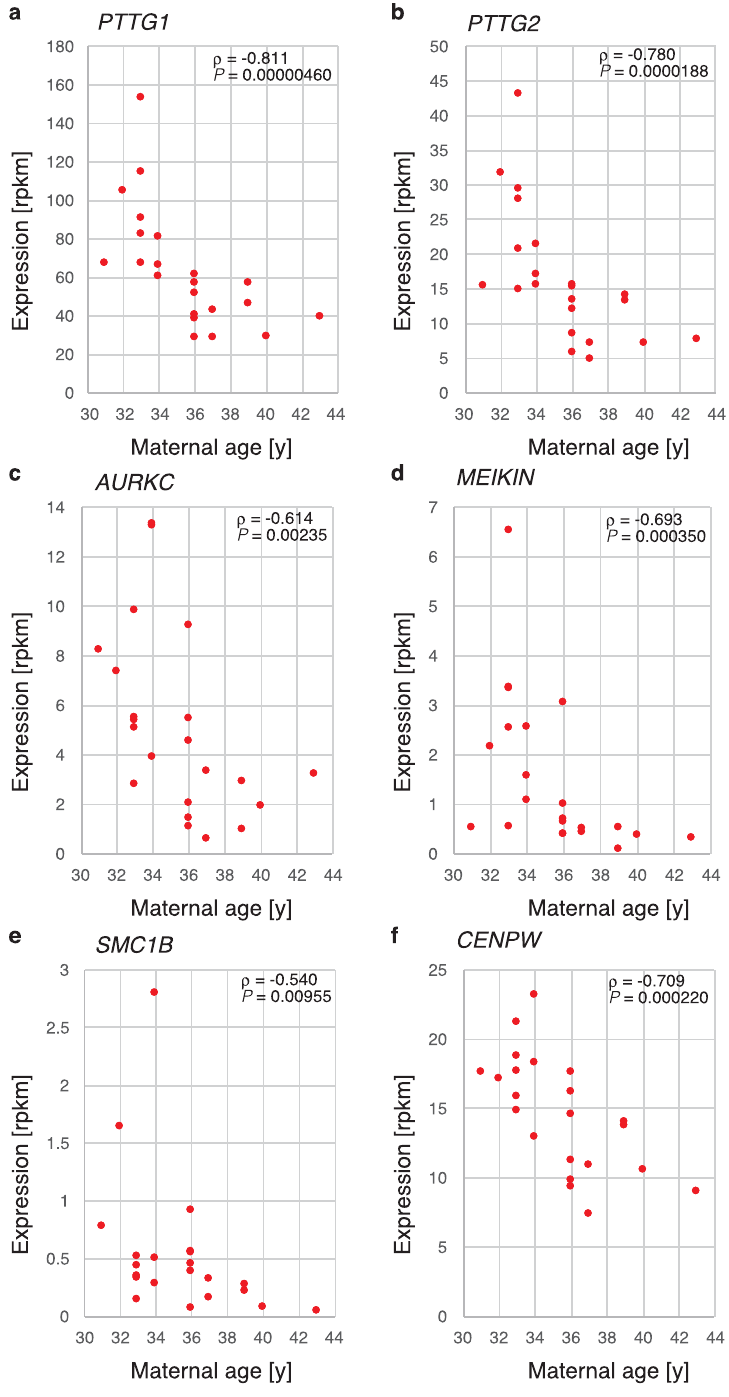
Figure 2. Genes that were down-regulated with advanced maternal age. The expression levels (in rpkm) were plotted against the maternal age for PTTG1 ( a ), PTTG2 ( b ), AUKRC ( c ), MEIKIN ( d ), SMC1B ( e ) and CENPW ( f ). The correlation coefficient ρ and P value between the expression and ages are also presented in each